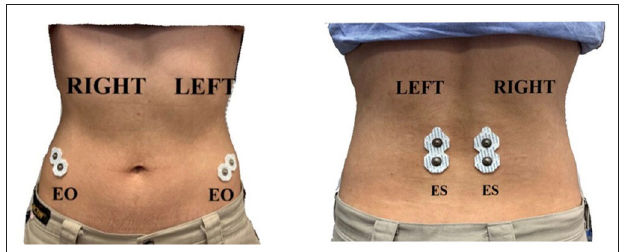
FIGURE 1 | Placement of surface EMG electrodes. EO, external oblique muscle; ES, erector